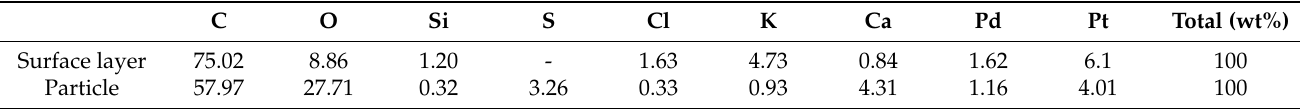
Figure 7. SEM images of ( A ) adaxial surface layer of Ardisia japonica leaf and ( B ) particle on the leaf surface under CL (continuous light) with drought. Table 1. Elemental compositions of the adaxial surface layer of Ardisia japonica leaf and leaf surface particle under CL (continuous light) with drought.